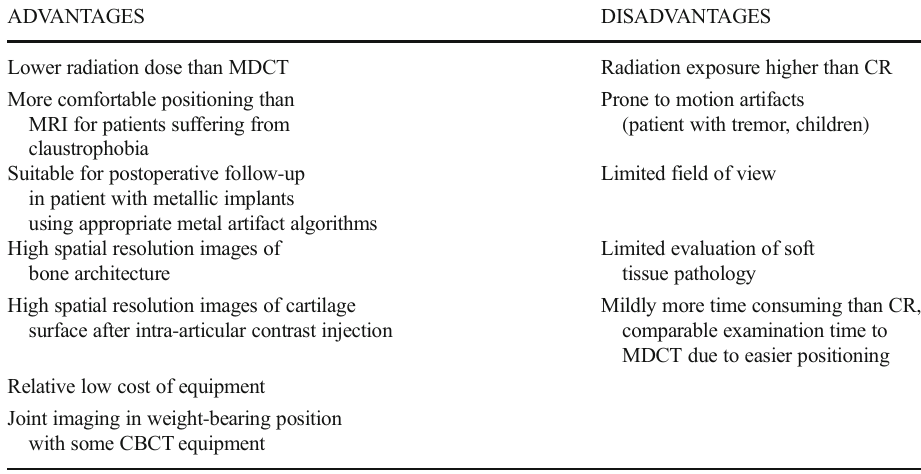
Table 2 Advantages and disadvantages of musculoskeletal